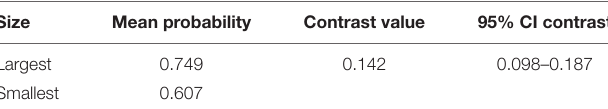
TABLE 5 | The size contrast in experiment 2.